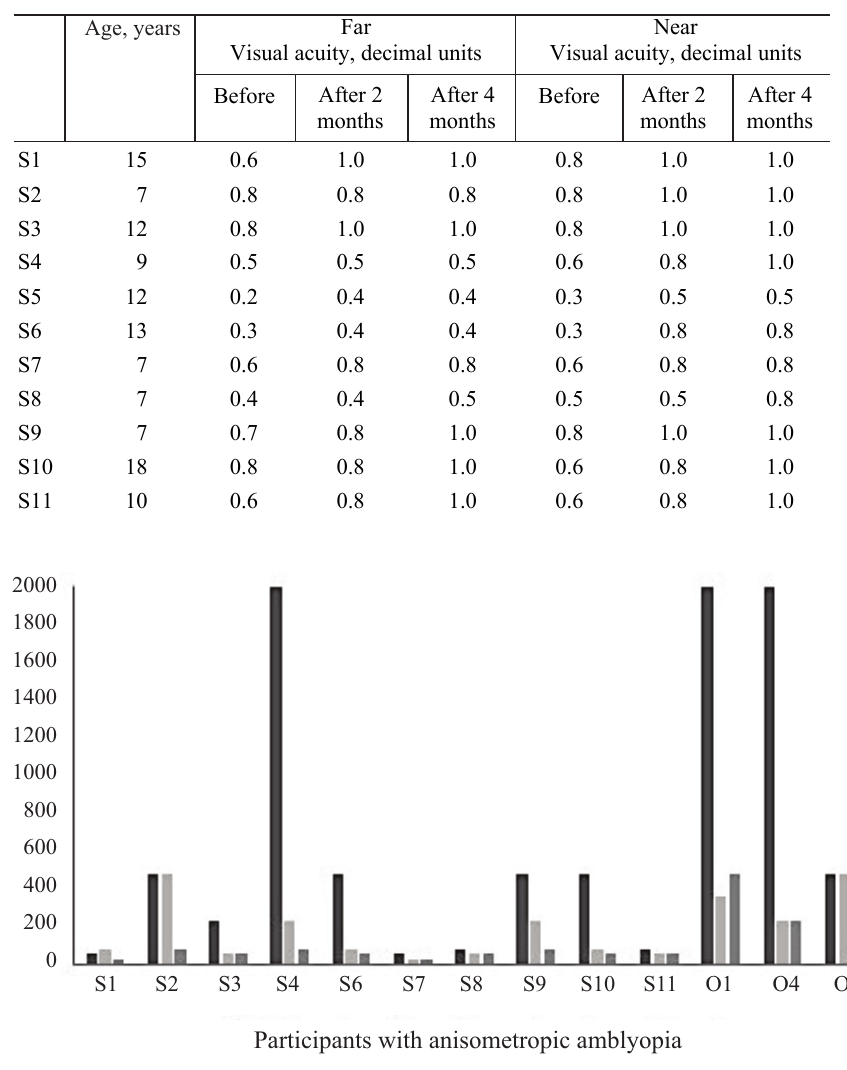
Table 2. Visual acuity evaluation results for far and near in participants with specialized